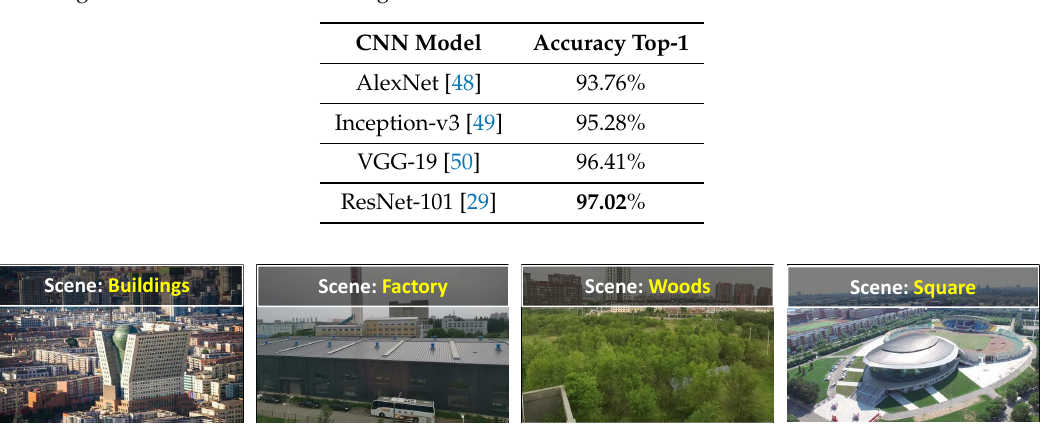
Table 8. Comparative experimental results of scene understanding algorithms when dataset Place365 is categorized into 6 classes according to Table 1.